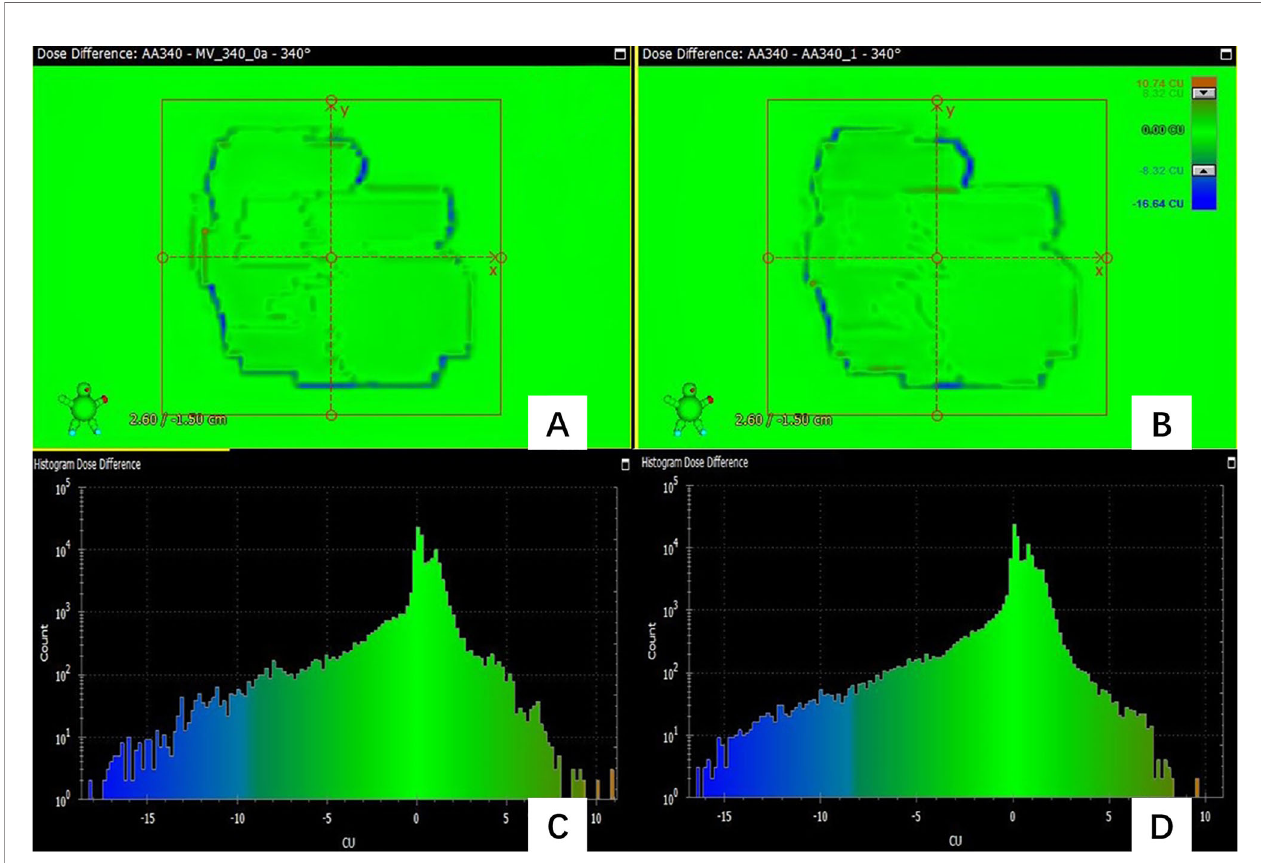
FIGURE 4 | (A) the dose difference between the measured planar dose and TPS calculated (B) the dose difference between the predicted and TPS calculated planar dose. (C) the histogram of the dose difference between measured and TPS calculated planar dose for one pass fi eld (D) the histogram of the predicted planar dose relative to TPS calculated